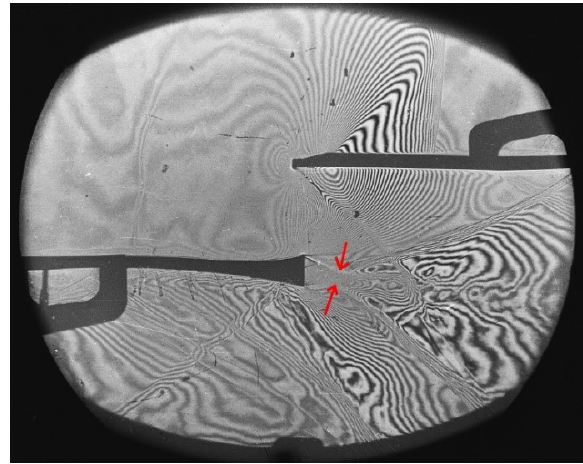
Figure 10. Section near the tip, ι = − 6 . 5 ◦ , M 1 . 51.